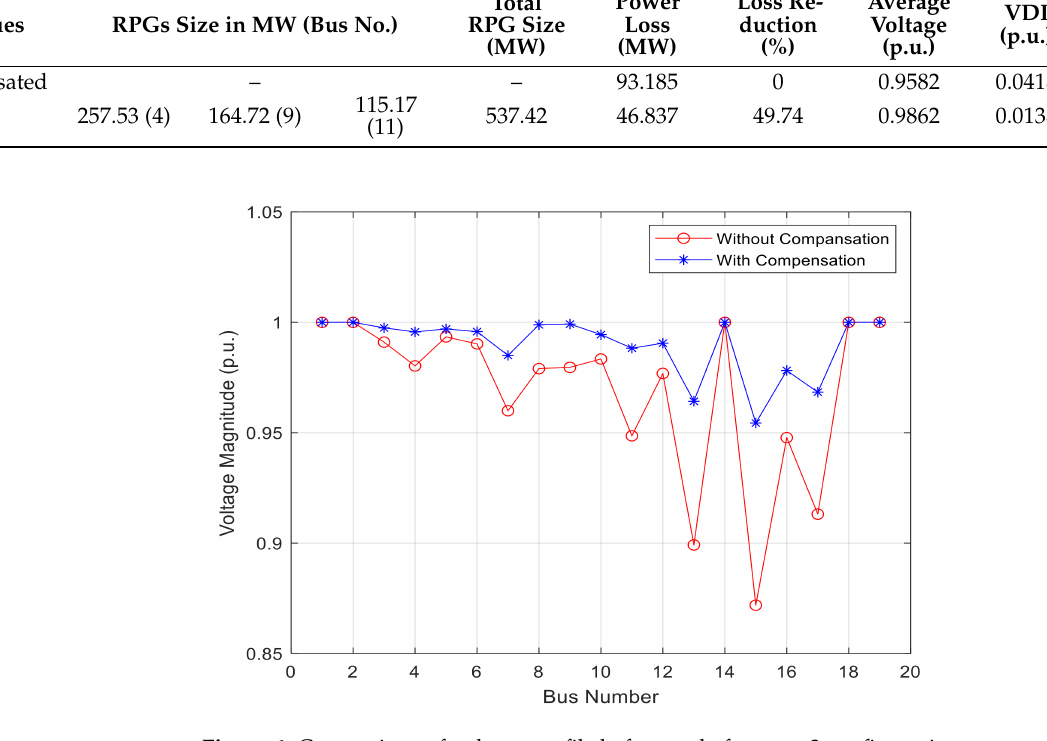
Figure 6. Comparison of voltage profile before and after case 2